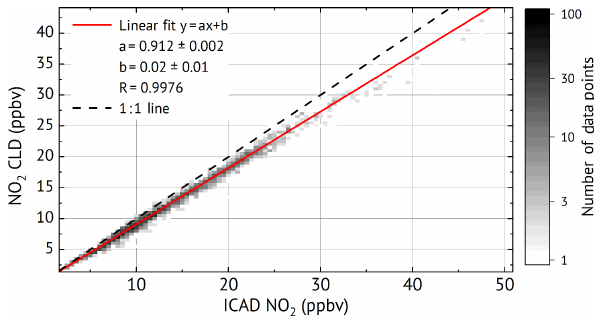
Figure 11. Time series for the long-term NO 2 comparison be- tween the ICAD NO 2 (instrument configuration 1) and a commer- cial CLD–BLC.